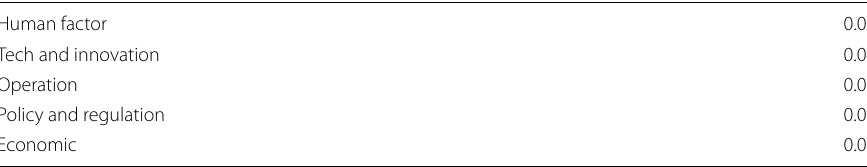
Table 13 Defuzzified mean value of weights of disciplines